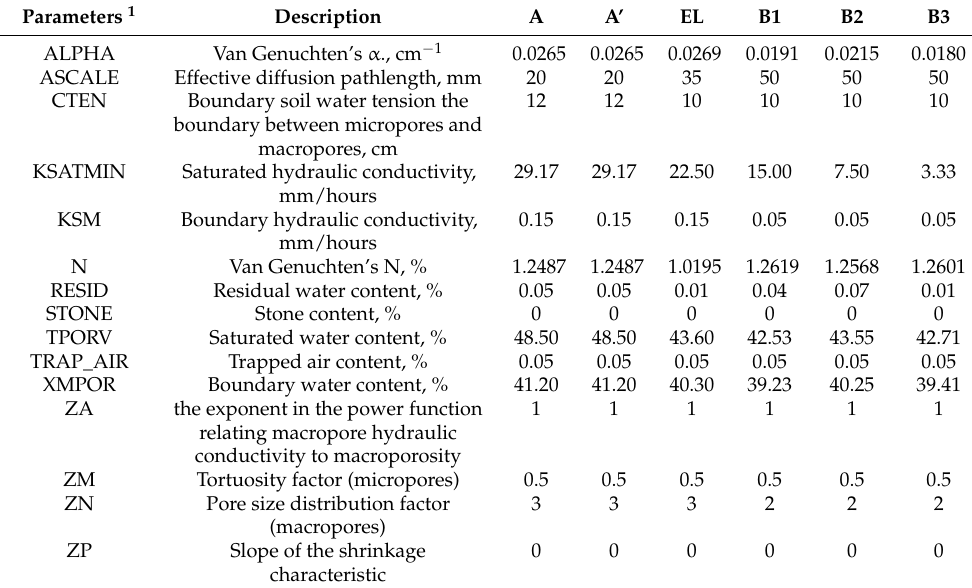
Table 2. Hydraulic parameters of Albic Glossic Retisol for MACRO